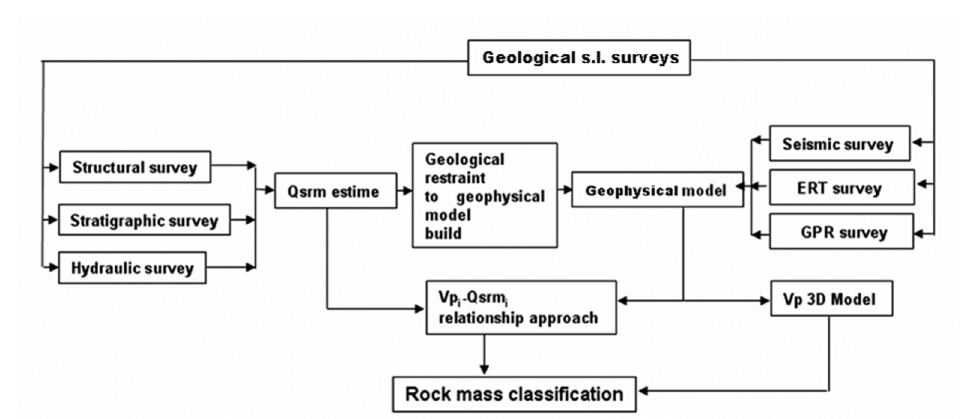
Fig. 2. Flowchart of methods to evaluate rock mass